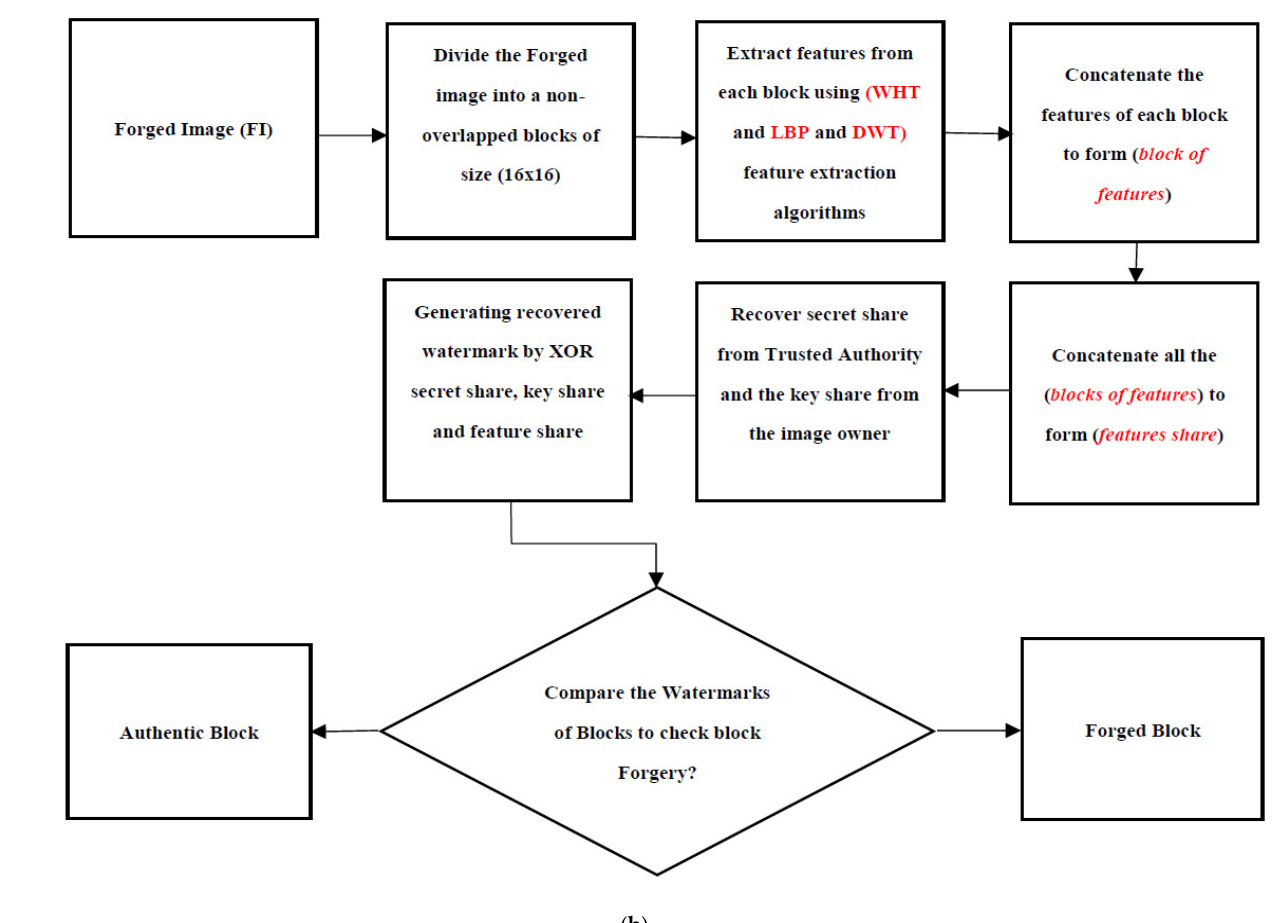
Figure 4. Block diagram of the proposed method: ( a ) Shares construction phase; ( b ) Image forgery verification.